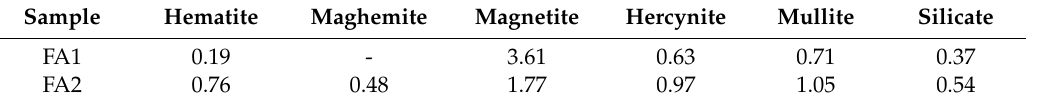
Table 4. Content of iron oxides (%) in the samples of fly ashes FA1 and FA2. Sample